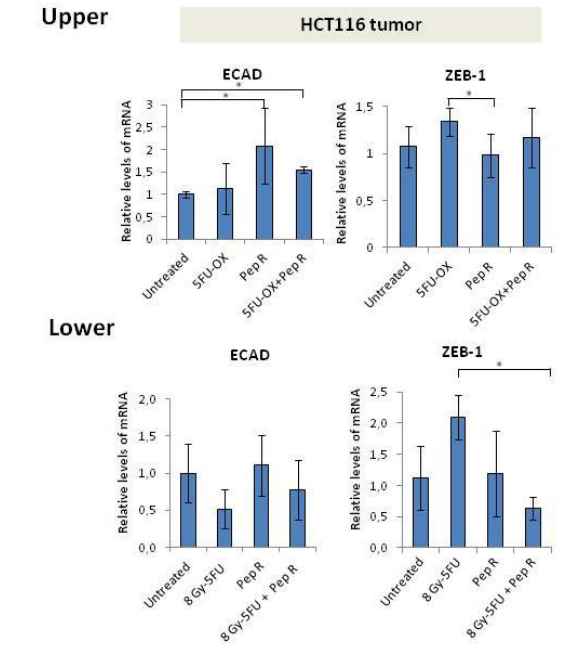
Figure 5. In vivo Peptide R modulates EMT-inducing genes in HCT116 human colon cancer xenograft. ( A ) Representative immunohistochemistry staining (200 × magnification) of membranous E-cadherin, nuclear ZEB1 in tumor cells of invasive tumor regions; cytoplasmic CD90 (brown staining). Bar graph illustrating quantification of IHC staining from collected tumors (means ± SD) . A p -value < 0.05 (*) was considered statistically significant (Kruskal-Wallis test followed by Dunn’s multiple comparison). Percentage of stained cancer cells y axis (y-axis); treatments (y-axis). ( B ) RNA expression for ECAD and ZEB-1 expression in HCT116 tumors. Bar graph illustrating relative mRNA expression levels (qRT-PCR) of indicated genes (means ± SD). The 2 - ∆∆ CT method was used as a relative quantification. Triple determination each point / gene were performed. A p -value < 0.05 (*) was considered statistically significant.